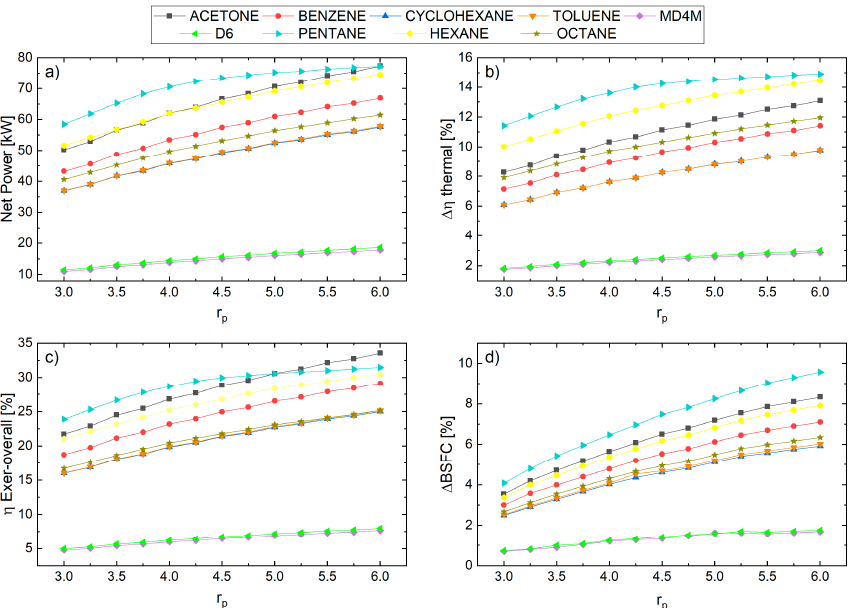
Figure 6. Performance of the RORC configurations with different working fluids and varying pressure ratios. ( a ) Net power; ( b ) Absolute increase in thermal efficiency; ( c ) Overall exergetic efficiency; and ( d ) Specific engine fuel consumption-ORC.